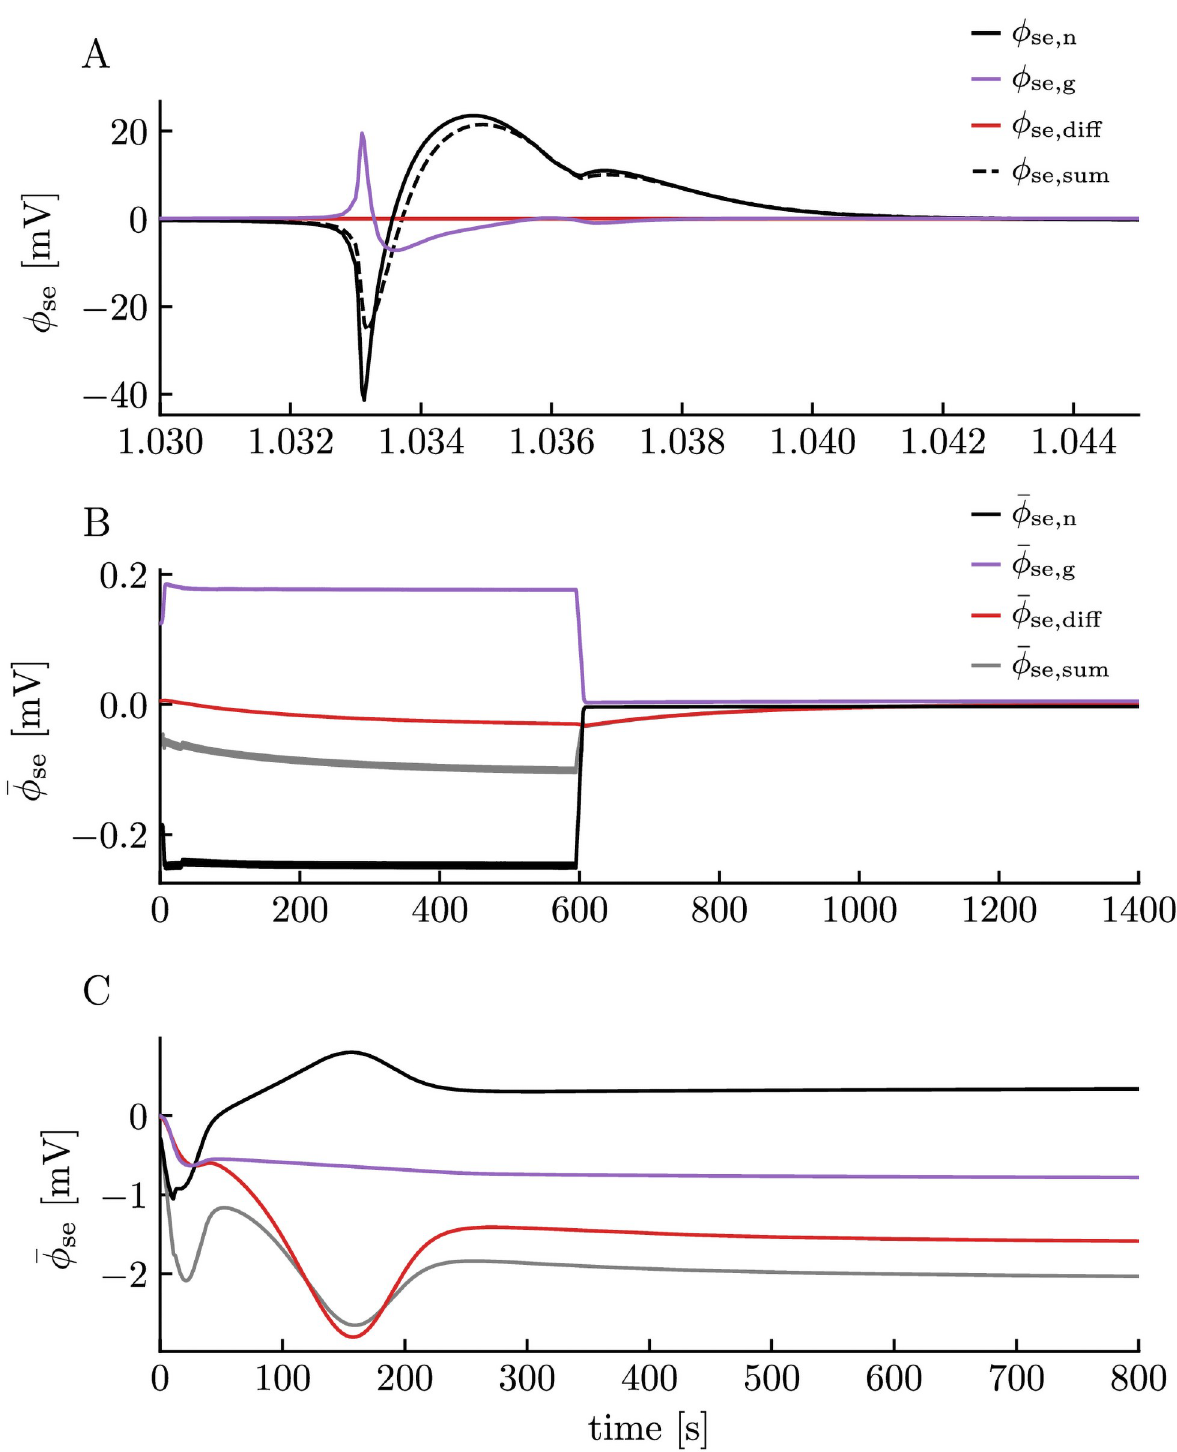
Fig 5. Neuronal, glial, and diffusive components of the extracellular potential. (A) The extracellular potential, split into components explained by standard volume conductor (VC) theory and neuronal currents ( ϕ se,n ), VC theory and glial currents ( ϕ se,g ), and a “correction” term explained by diffusive currents ( ϕ se,diff ). The sum of the three components ( ϕ se,sum ) is equal to the extracellular potential calculated in the edNEG model. See the Methods section for a description of how we calculated ϕ se,n , ϕ se,g , and ϕ se,diff . The simulation was the same as in Fig 3. (B) The neuronal ( �